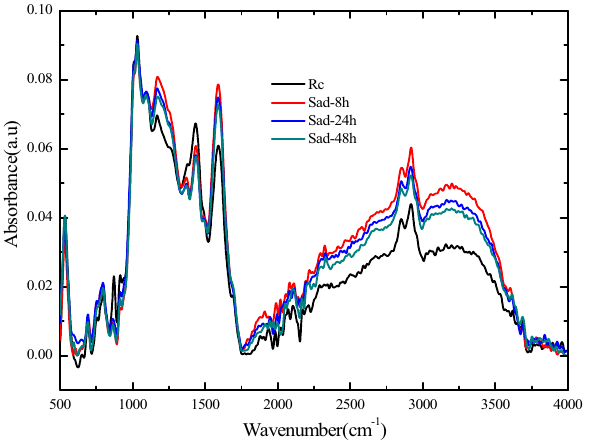
Figure 2. FTIR spectra of coal samples tested in the experiment. Sample label Rc represents the test result of raw coal; Sad-8 h represents the test result after drying for 8 h in the air environment after saturation; Sad-24 h represents the test result after drying for 24 h in the air environment after saturation; and Sad-48 h represents the test result after drying for 48 h in the air environment after